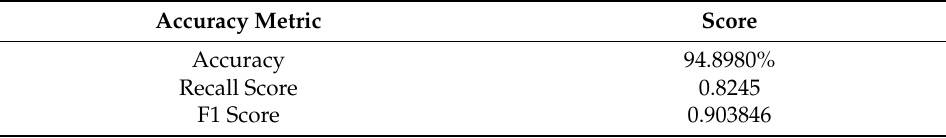
Figure 18. ( a ) Training loss curve, ( b ) validation loss curve, and ( c ) confusion matrix of validation data for ResNet50 model. Table 4. Accuracy metric readings of ResNet50. Table 4. Accuracy metric readings of ResNet50.